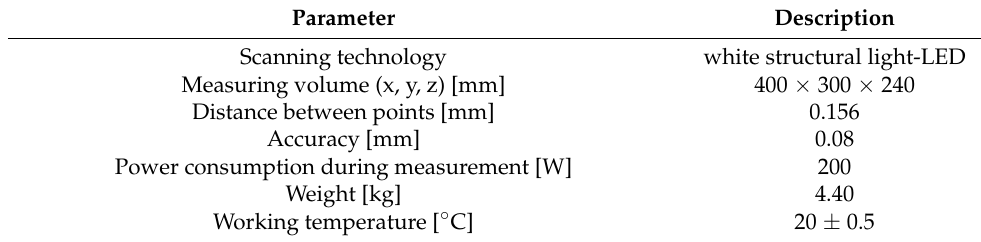
Table 1. Technical specification of 3D scanner.